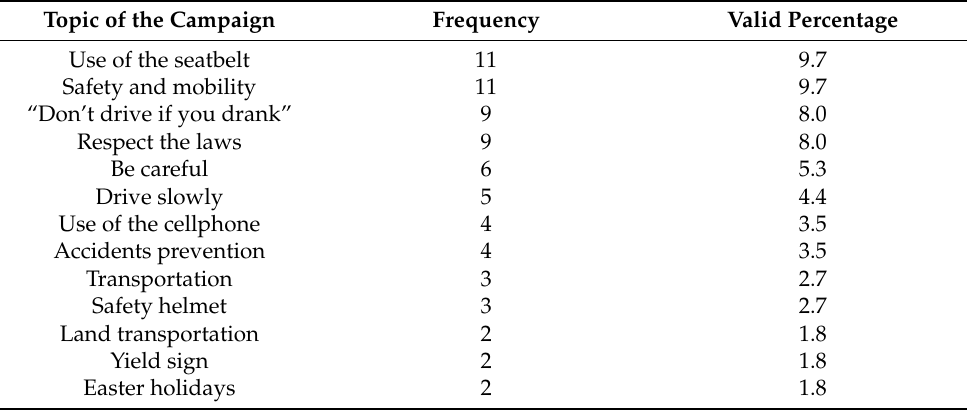
Table 2. Topics addressed by the traffic safety campaigns remembered by population.